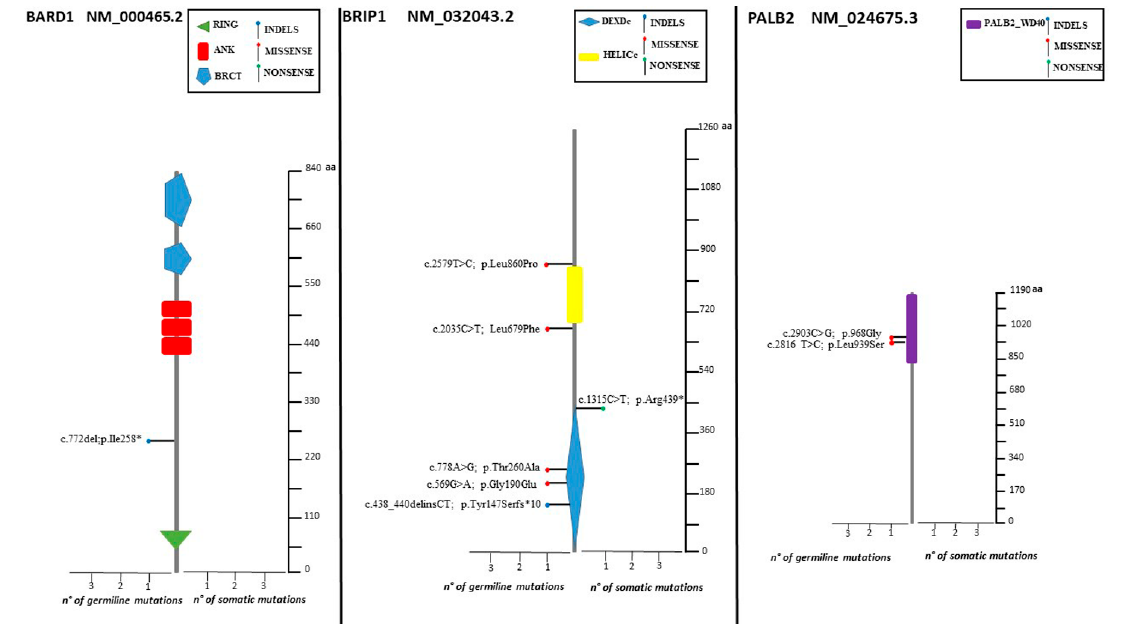
Figure 3. Lolliplots showing germline and somatic variant spectrum (both pathogenic and VUS) throughout the whole protein sequences of BARD1 , BRIP1 , and PALB2 . The vertical black scale bar represents the length (amino acids) of the protein sequence. The horizontal bar represents the number of patients affected by the specific mutation. Each lolliplot represents a variant identified in this study. The blue lolliplot identifies a shorts indels mutation (deletion or duplication). The red lolliplot indicate a missense variant, while the green ones a nonsense mutation.